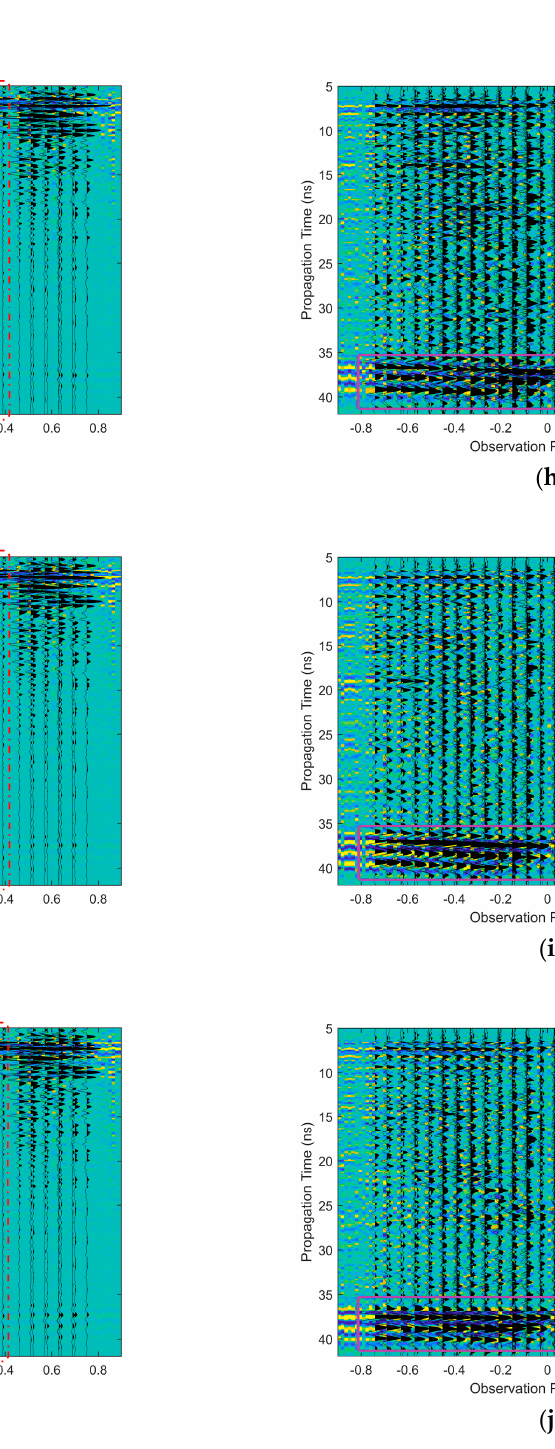
Figure 8. Wiggle figure on 132 channels’ echoes corresponding to five stations: ( a – e ) are the initial echos, ( f – j ) are the optimal echoes.